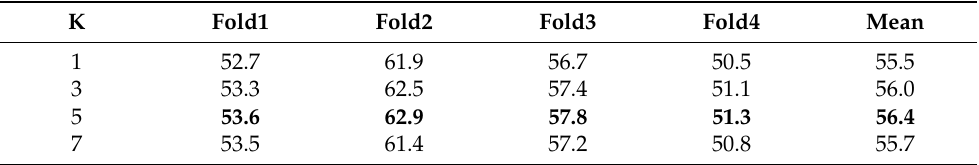
Table 9. Ablation studies on the hyper-parameter k in pseudo-label generation. Bold numbers represent the best data in the comparison experiment.